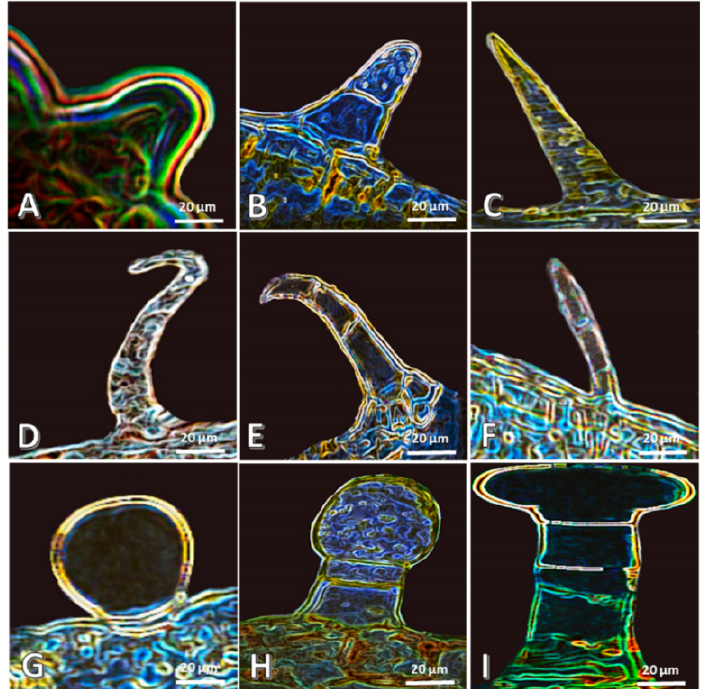
Figure 3. Di ff erent trichomes of the studied Apocynaceous plants examined by the light microscope at 140 × . ( A – C ): N. oleander , ( D ): A. obesum , ( E – H ): A. curassavica , and ( I ): C. procera